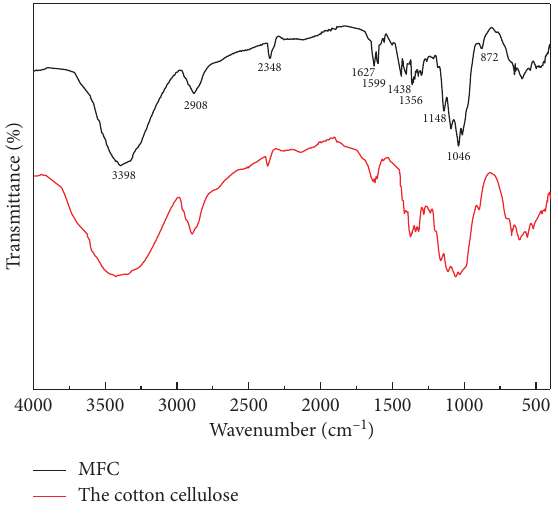
Figure 5: FTIR spectra of MFC and cotton